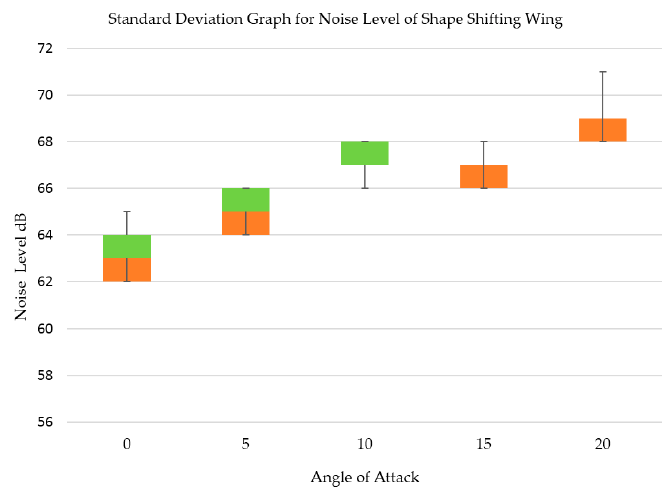
Figure 31. A graph showing the standard deviation of noise level for the shape shifting wing.